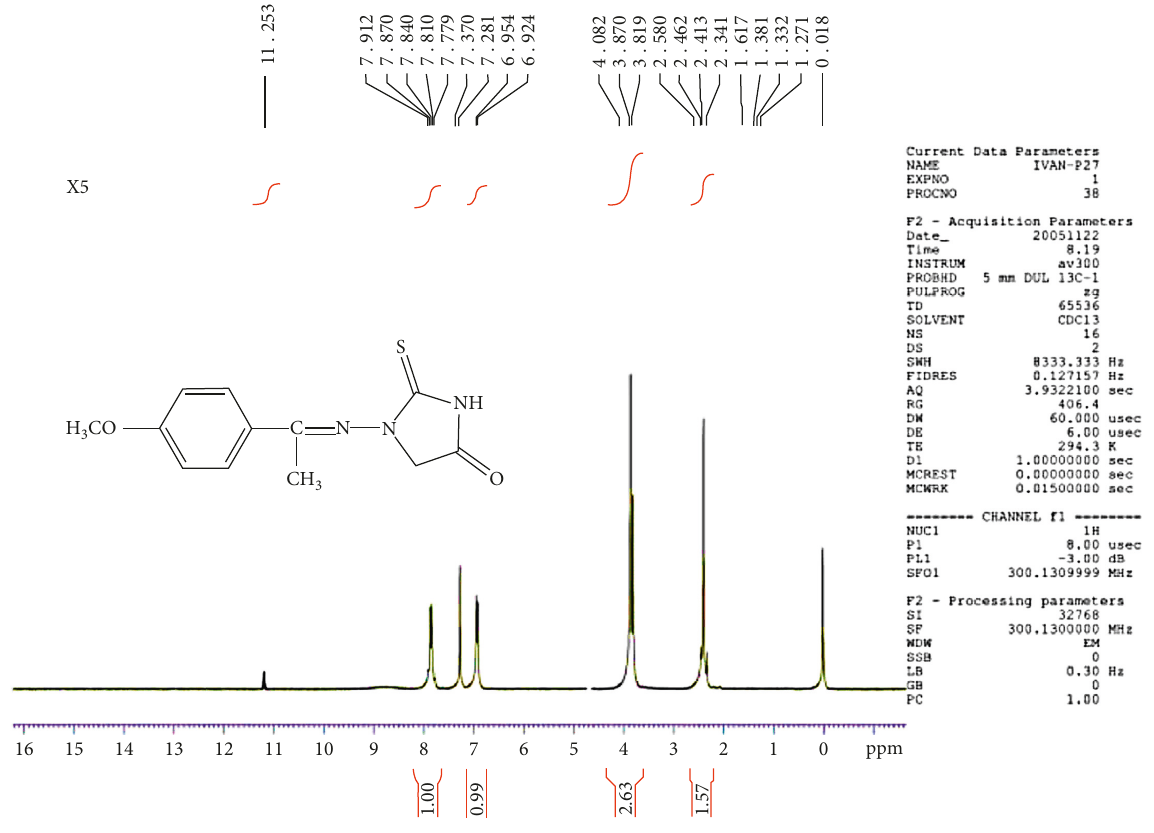
Figure 7: 1H-NMR spectrum of the C6 compound.